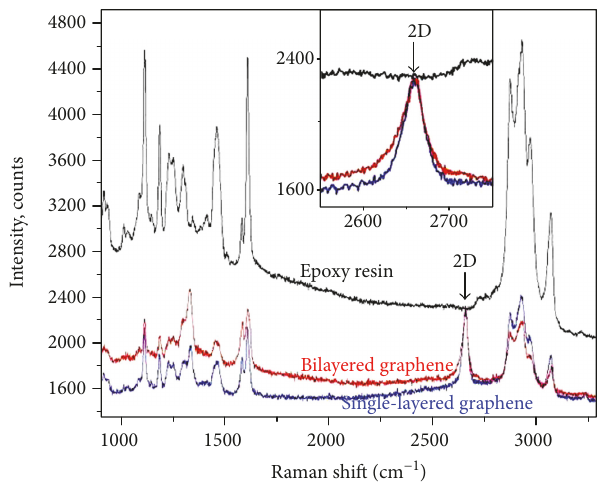
Figure 8: Raman spectra of graphene fi lms situated on air bubbles/cavities. The 2D band is situated at 2655cm − 1 and has FWHM ~ 28cm − 1 (i.e., it corresponds to single-layered graphene — blue